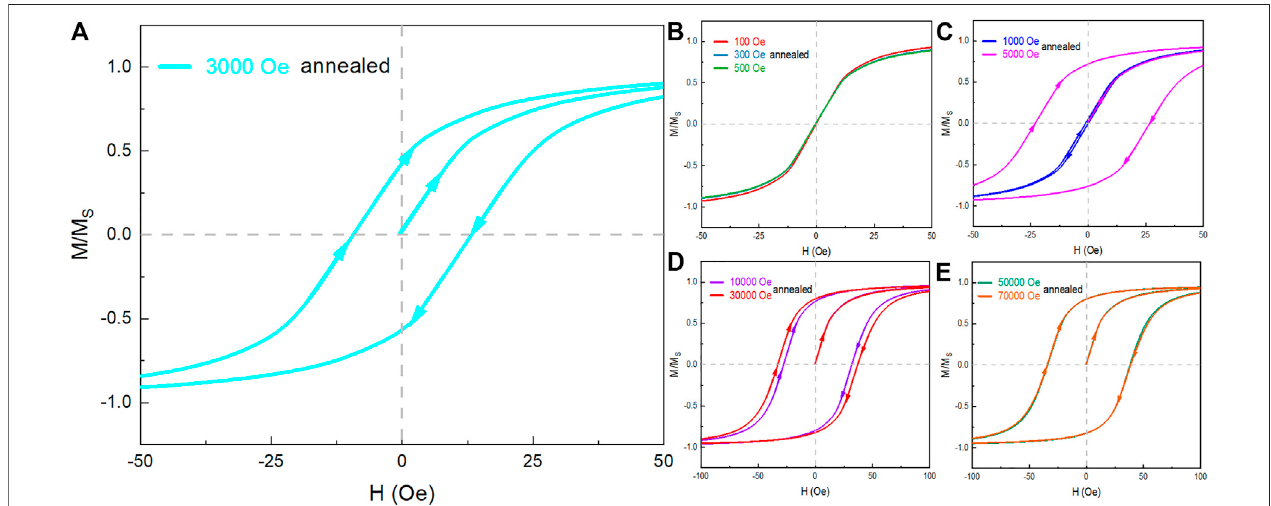
FIGURE 2| Aseriesof normalized M ( H ) loops enlarged near the origin for different scanning fi eld ranges of nanocrystalline Fe 73.5 Cu 1 Nb 3 Si 13.5 B 9 sampleat 300 K. The arrows stuck to the curve represent the direction of the fi eld sweep. (A) Normalized M ( H ) loops for H FR (cid:1) 3000 Oe of nanocrystalline Fe 73.5 Cu 1 Nb 3 Si 13.5 B 9 sample. The phenomenon of inverted hysteresis loop can be observed clearly. (B – E) Hysteresis loops measured under different scan fi eld ranges. At low scan fi elds, inverted hysteresis loop is absent as shown in (B) , while for higher scan fi elds in (C – E) , the loop is inverted.